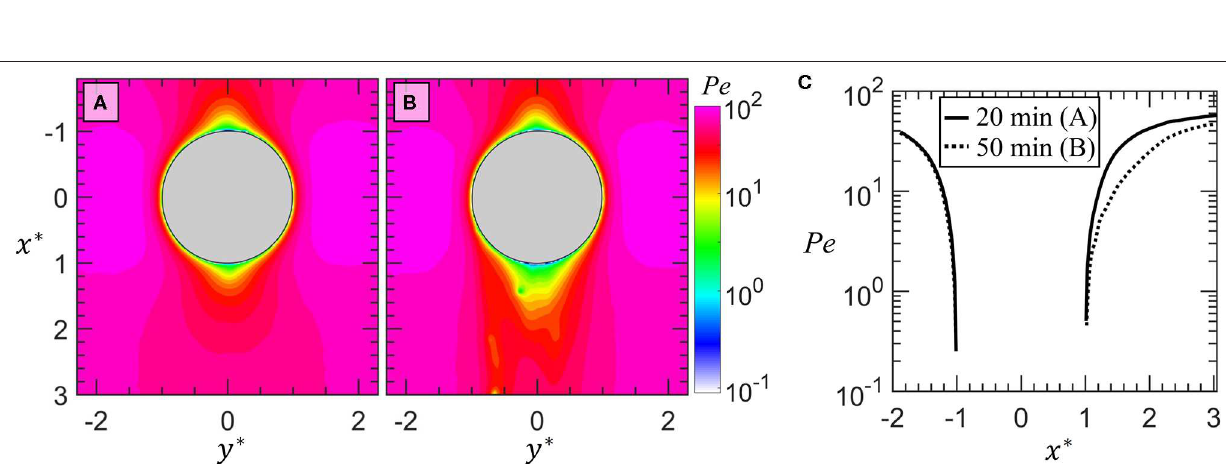
0 (i.e. through the center of the drop) is shown =